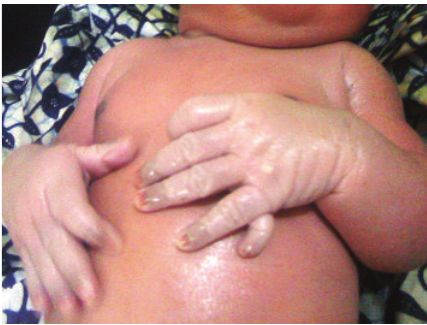
Figure 1: The 6 digits of left hand. The cutaneous nubbin is seen on the ulnar side of both hands.